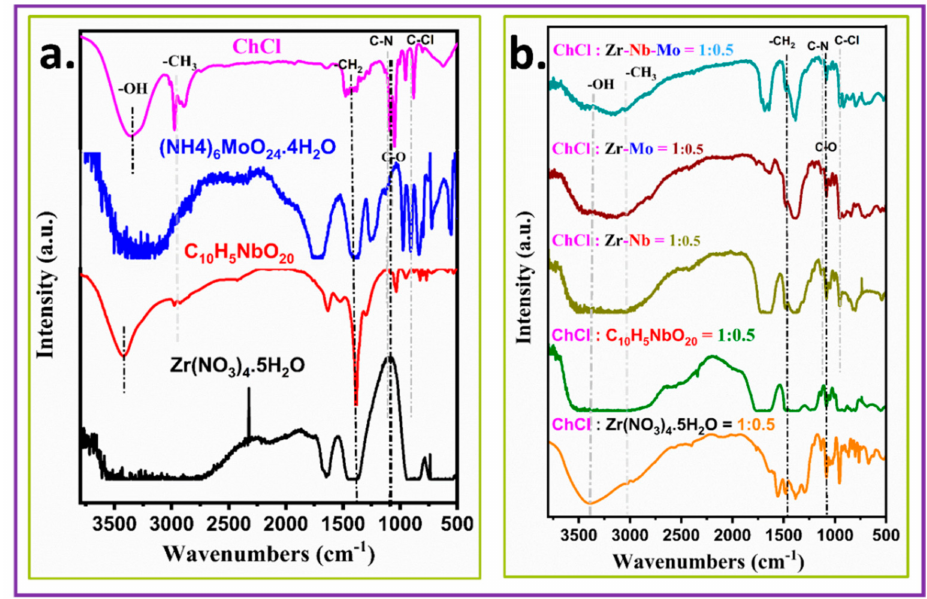
Figure 1. FTIR spectra of the hydrogen bond acceptor (ChCl) and hydrogen bond donors (Zr(NO 3 ) 4 · 5H 2 O, (NH 4 ) 6 MoO 24 · 4H 2 O, and C 10 H 5 NbO 20 ) ( a ), and a eutectic mixture of hydrogen bond acceptor and hydrogen bond donor at a molar ratio of 1:0.5 ( b